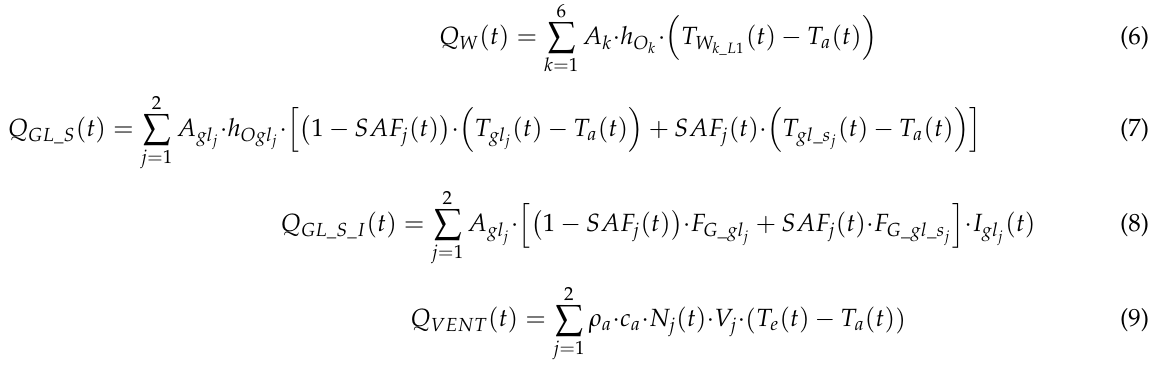
Table 4. Thermal model parameters (Equations